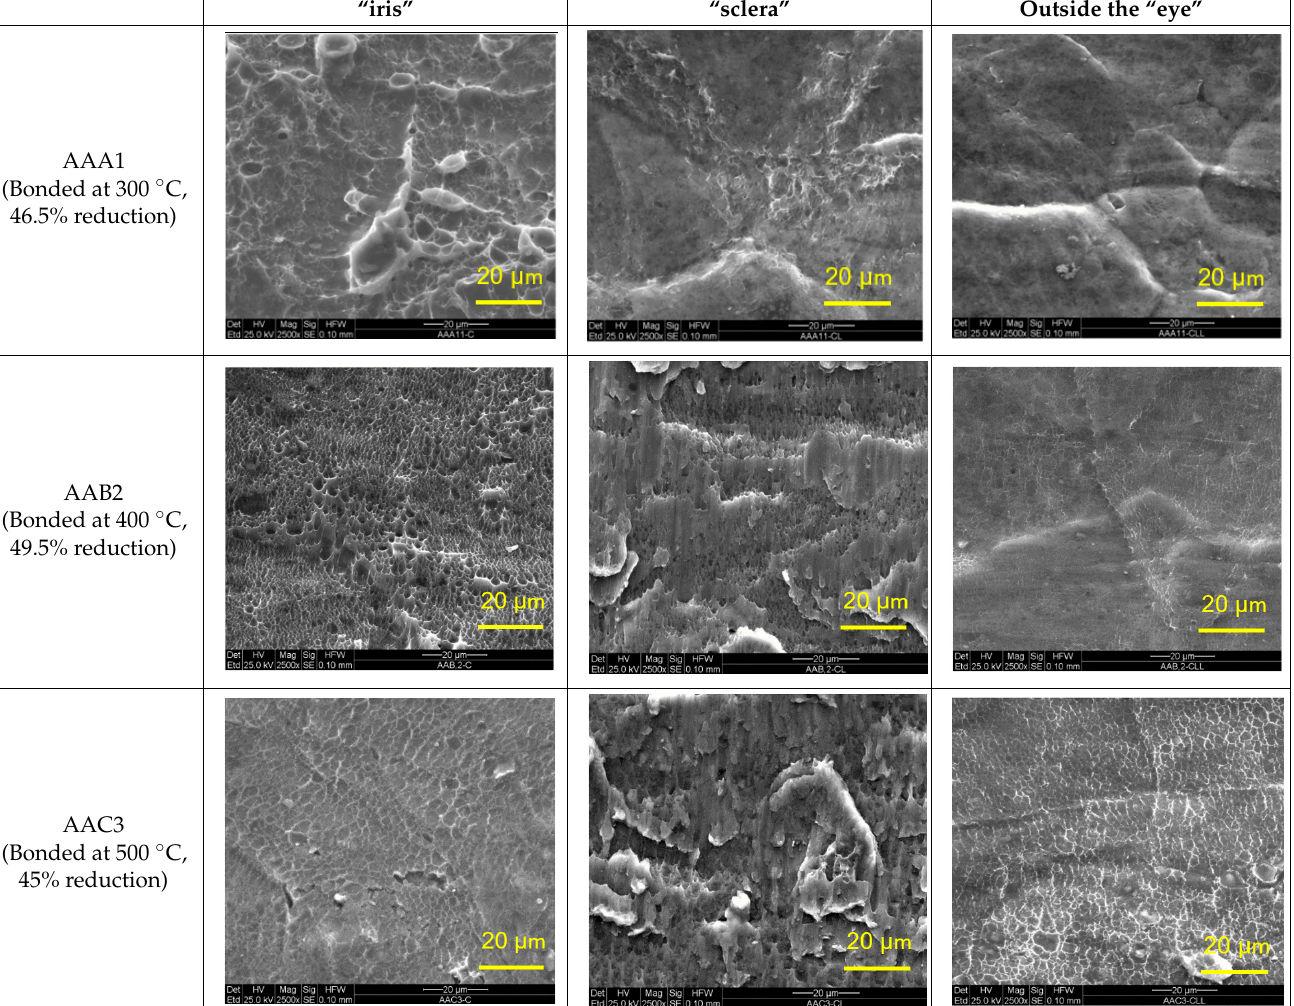
Table 4. SEM images of different areas of the interface after debonding, magnification ×2500. “iris”